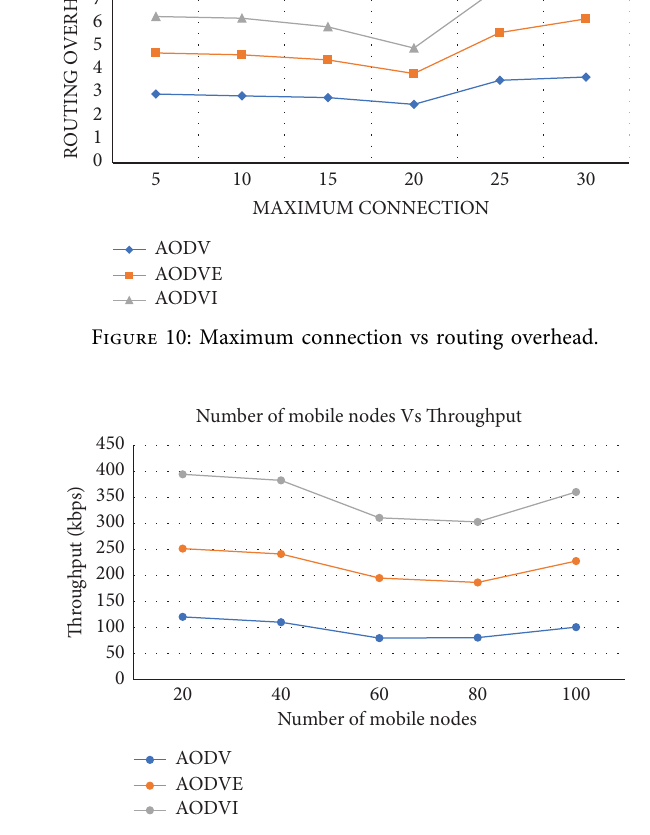
Figure 11: Number of mobile nodes vs